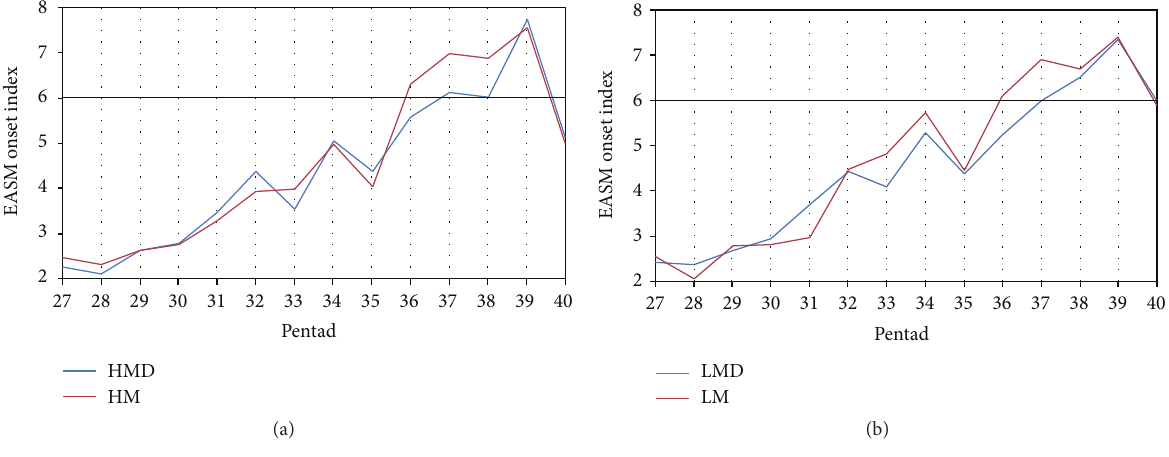
Figure 13: As in Figure 10 but for the northern monsoon region (34 ∘ –42 ∘ N, 105 ∘ –120 ∘ E).